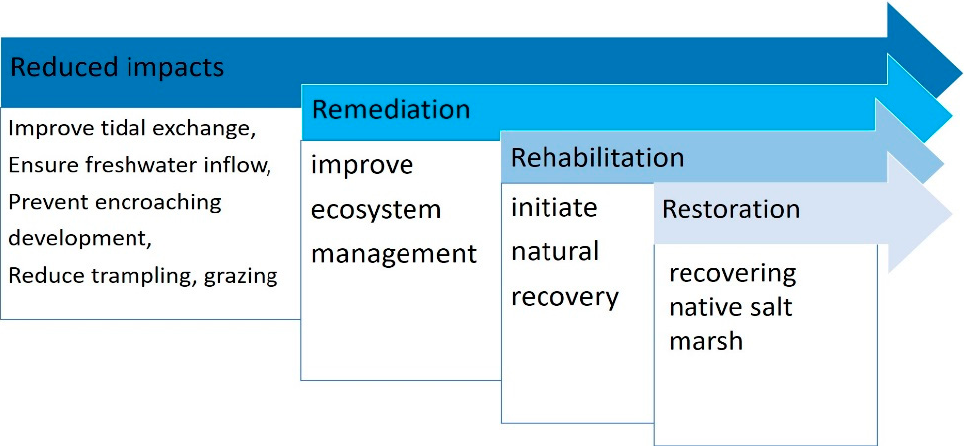
Figure 1. Restorative continuum to improve salt marsh biodiversity, health and ecosystem services (adapted from Society for Ecological Restoration, [16]).